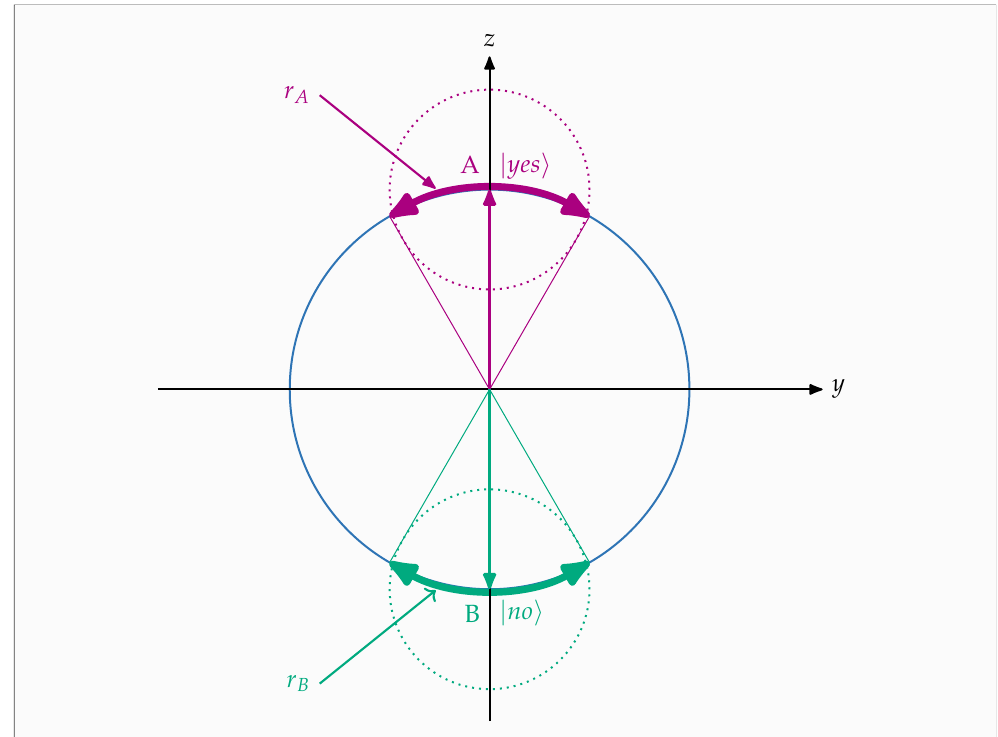
Figure 1. This figure provides a 2-dimensional visual representation of the free will radii. Represen- tatives from party A need not vote | yes (cid:105) , but their vote must be within a distance of r A from | yes (cid:105) , that is on the shaded red portion of the circle. Symmetrically, legislators from party B may not vote | no (cid:105) , but their vote must be within a distance of r | no (cid:105) , that is on the shaded green portion of B from the